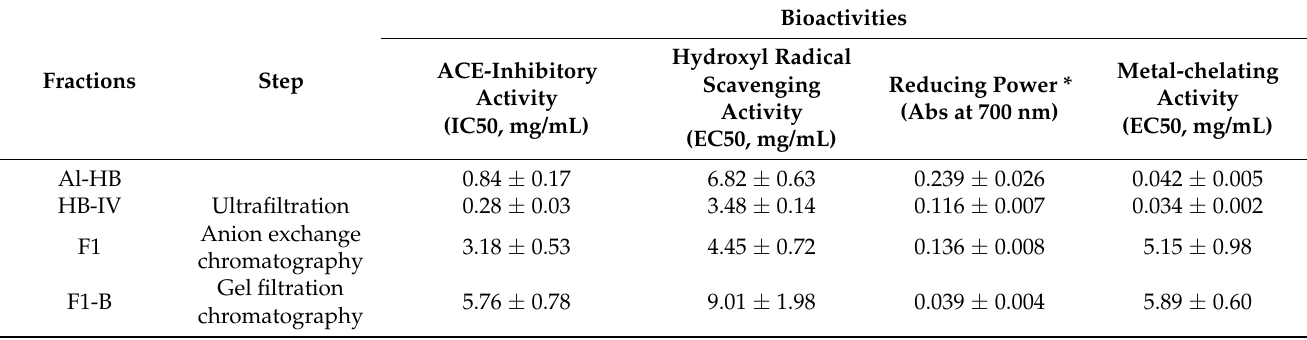
Table 4. Summary for bioactivities of the potent fraction collected after a series of purification steps on bone